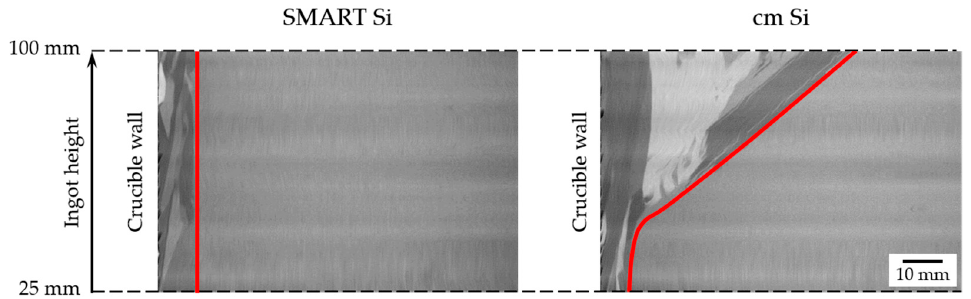
Figure 2. Virtual cut of grain structure measured via optical images through the bricks with SMART Si ( left ) and cm Si structure ( right ). The border between mono- and multicrystalline area is indicated by the red lines.